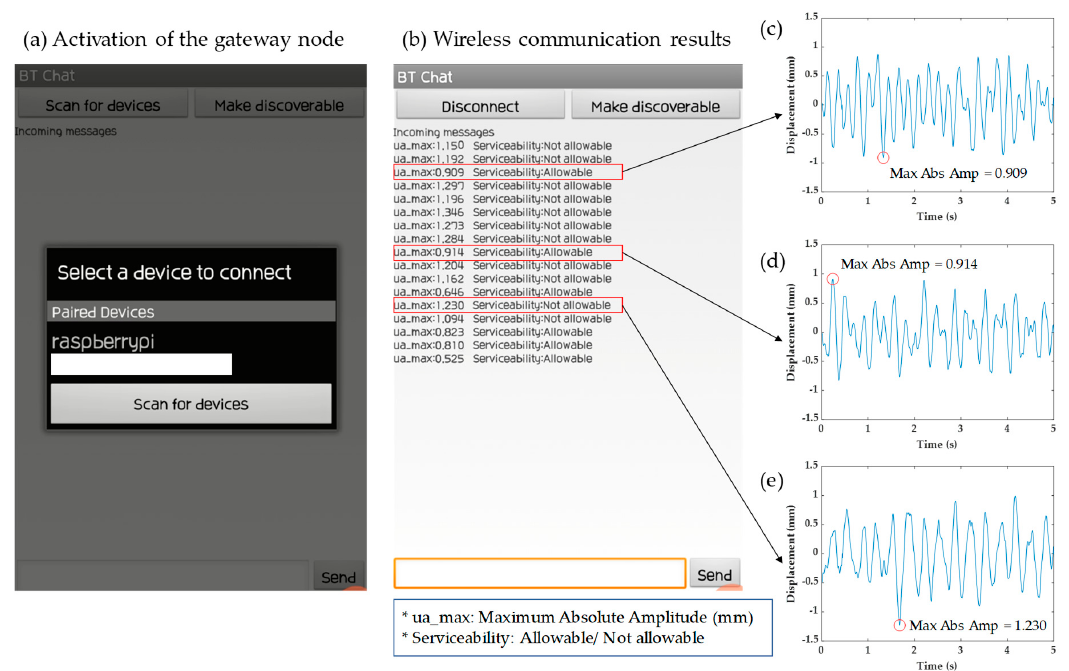
Figure 6. Wireless communication results of serviceability assessment for serviceability threshold of 1 mm . 270